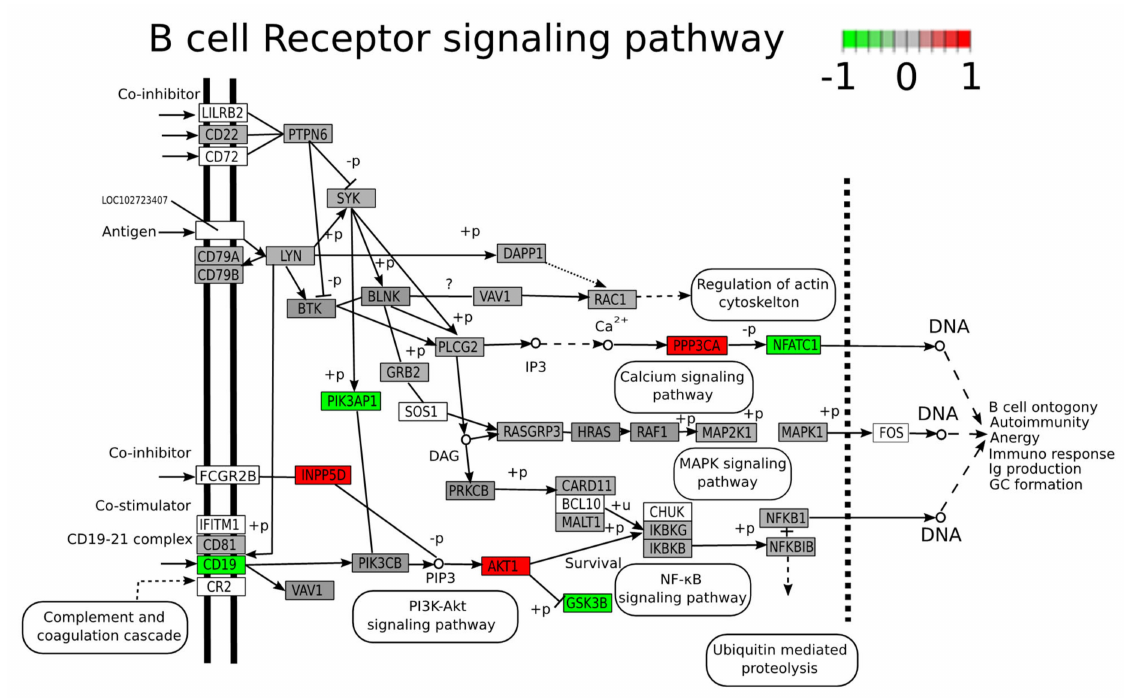
Figure A9. B-cell receptor signaling pathway with identified proteins from whole cells color coded according to log 2 fold change. Log 2 fold change from nonsignificantly regulated proteins based on the adjusted p value were set to zero before plotting with the R package Pathview.